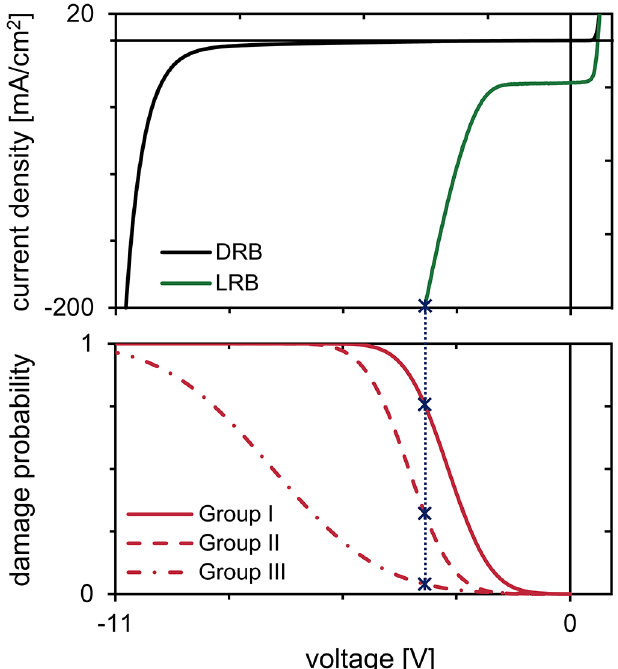
Fig. 4. The top graph shows typical JV curves of illuminated and dark reverse characteristic. The red curves plotted on the bottom graph represent the damage probability in the dark. The damage probability is the accumulated normal distribution from DRB measurements, a damage probability of 1 means a 100% chance of failure due to reverse bias. The blue dotted line shows the voltage at the current limit of the LRB JV